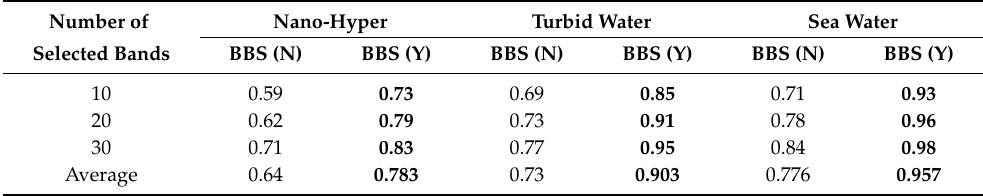
Average 0.273 0.507 The bold entries represent the best performance in each row. Table 5. The AUC values of the UTD results for confirming the effectiveness of SRRBSS. Number of Nano-Hyper Turbid Water Sea Water Selected